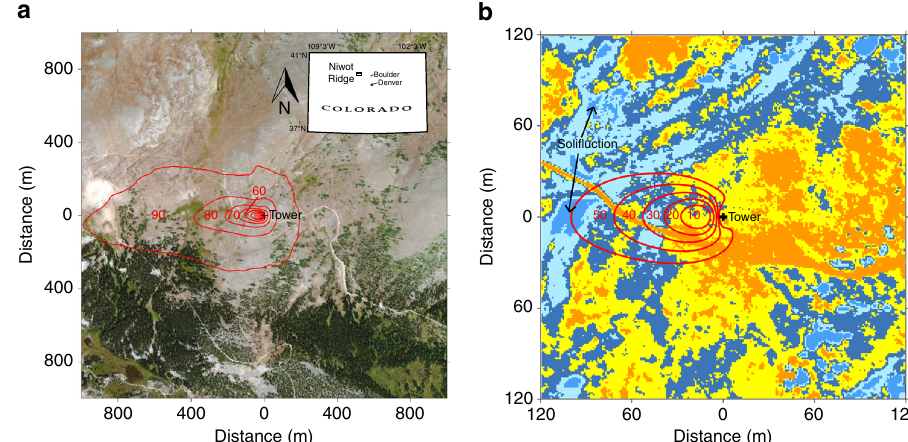
Fig. 1 Two-dimensional representation of the fl ux tower footprint. Contours denote the cumulative percent contribution (in red) of heterogeneous alpine tundra source areas to the net ecosystem exchange of carbon dioxide (NEE) fl ux between 1 January 2008 and 31 December 2009 55 . a Inset shows the location of Niwot Ridge in Colorado, USA (40°03 ′ N; 105°35 ′ W). Background image ©2018 Google. b A k-means clustering algorithm separates the tundra into fi ve unsupervised land cover classes based on the red-green-blue spectrum to demonstrate the scale of spatial heterogeneity in the area of peak measurement sensitivity 55 . Radiocarbon data were collected from areas of dry, moist, and wet meadow vegetation tundra including two soli fl uction lobes (labeled) associated with